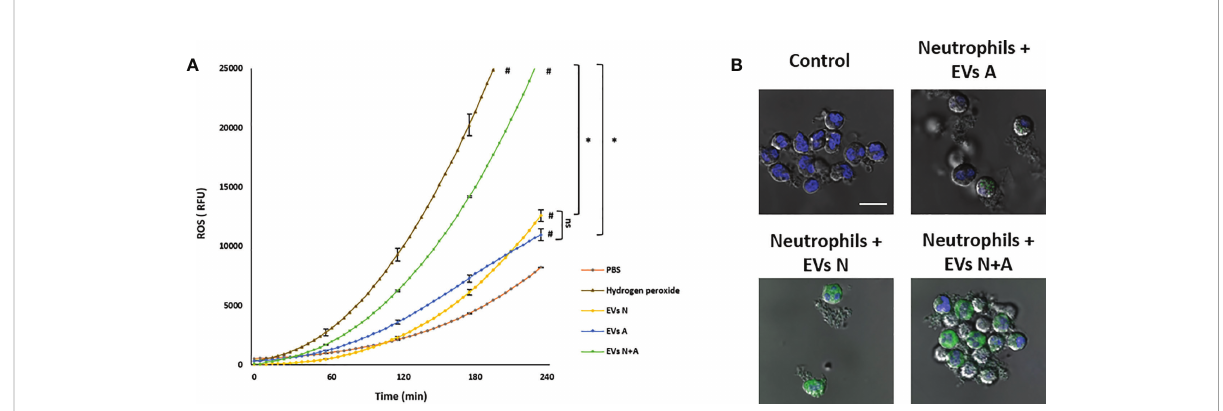
FIGURE 3 ROS detection in EVs from trophozoites, neutrophils and coculture and transfer to neutrophils. (A) Freshly isolated EVs (10 µg) were treated with H 2 DCFDA and fl uorescence was measured during 4 h and reported as fl uorescence relative units (FRU). PBS was used as background control and hydrogen peroxide as positive control. Graphs represent mean of three independent experiments and ± SD was placed every hour. #